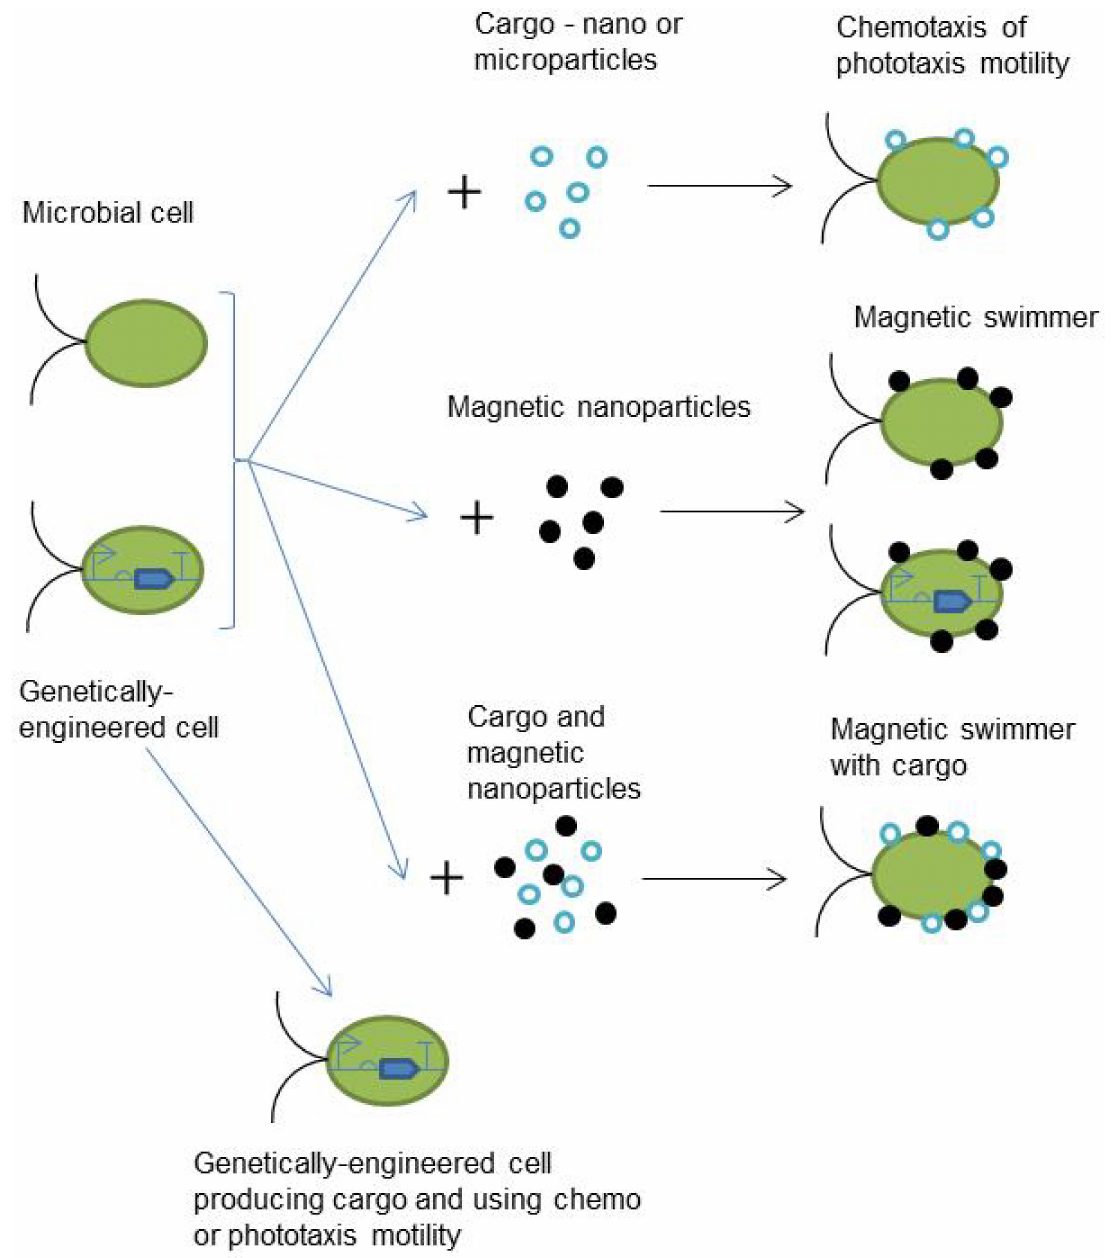
Figure 1. Most of the discussed variants of the microrobot design based on microbial cells. The goal of this review was to analyze the published results on microbial cell micro- robot development and discuss perspectives of this technology with respect to the current advances in synthetic biology and related